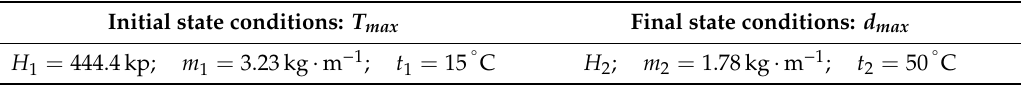
Table 8. Conditions for the cable RZ 3x150 Al / 80 Alm .